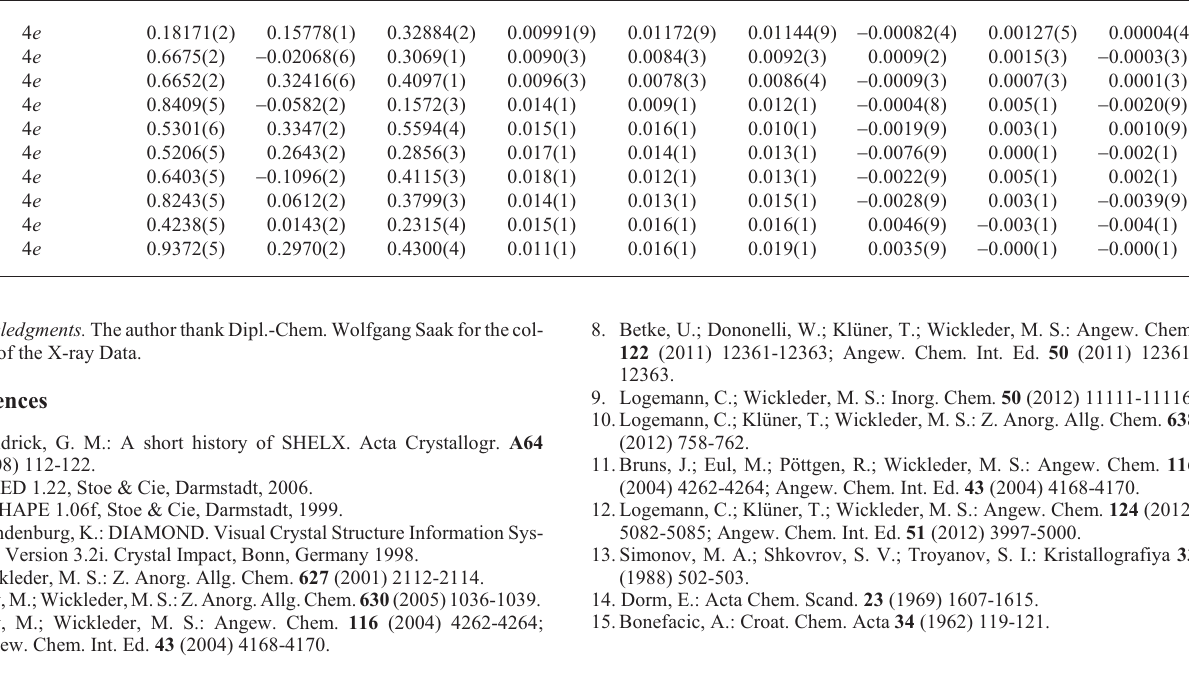
Table 2. Atomic coordinates and anisotropic displacement parameters (in Å 2 ) .